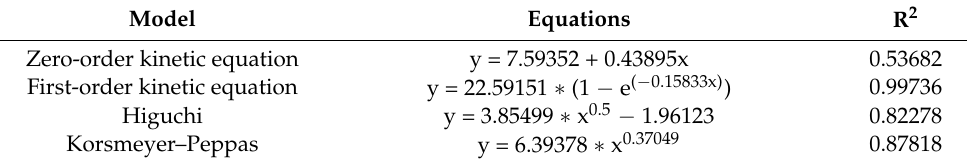
Table 2. Cumulative Release Curve Fitting Results of CE-NE In Vitro (pH